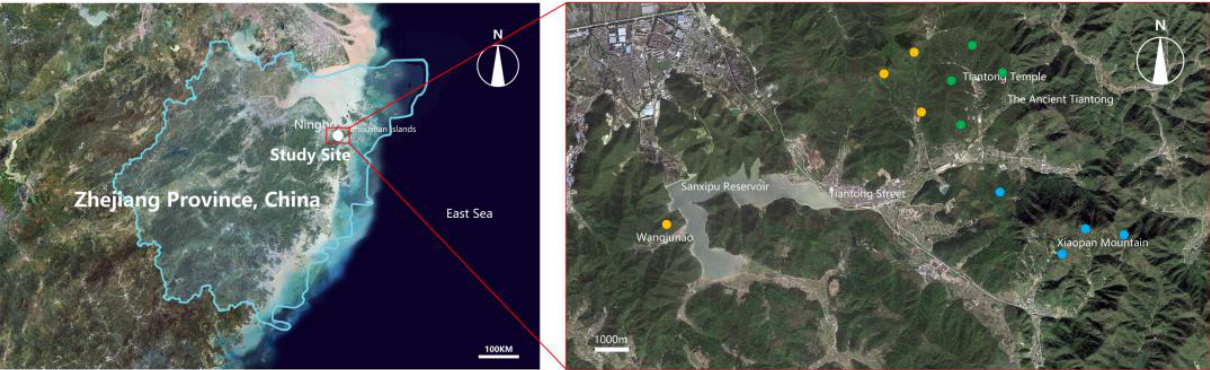
Figure 2. Map showing locations of study sites representing different types of disturbance (green = mature forests, yellow = shrublands, and blue = plantations).